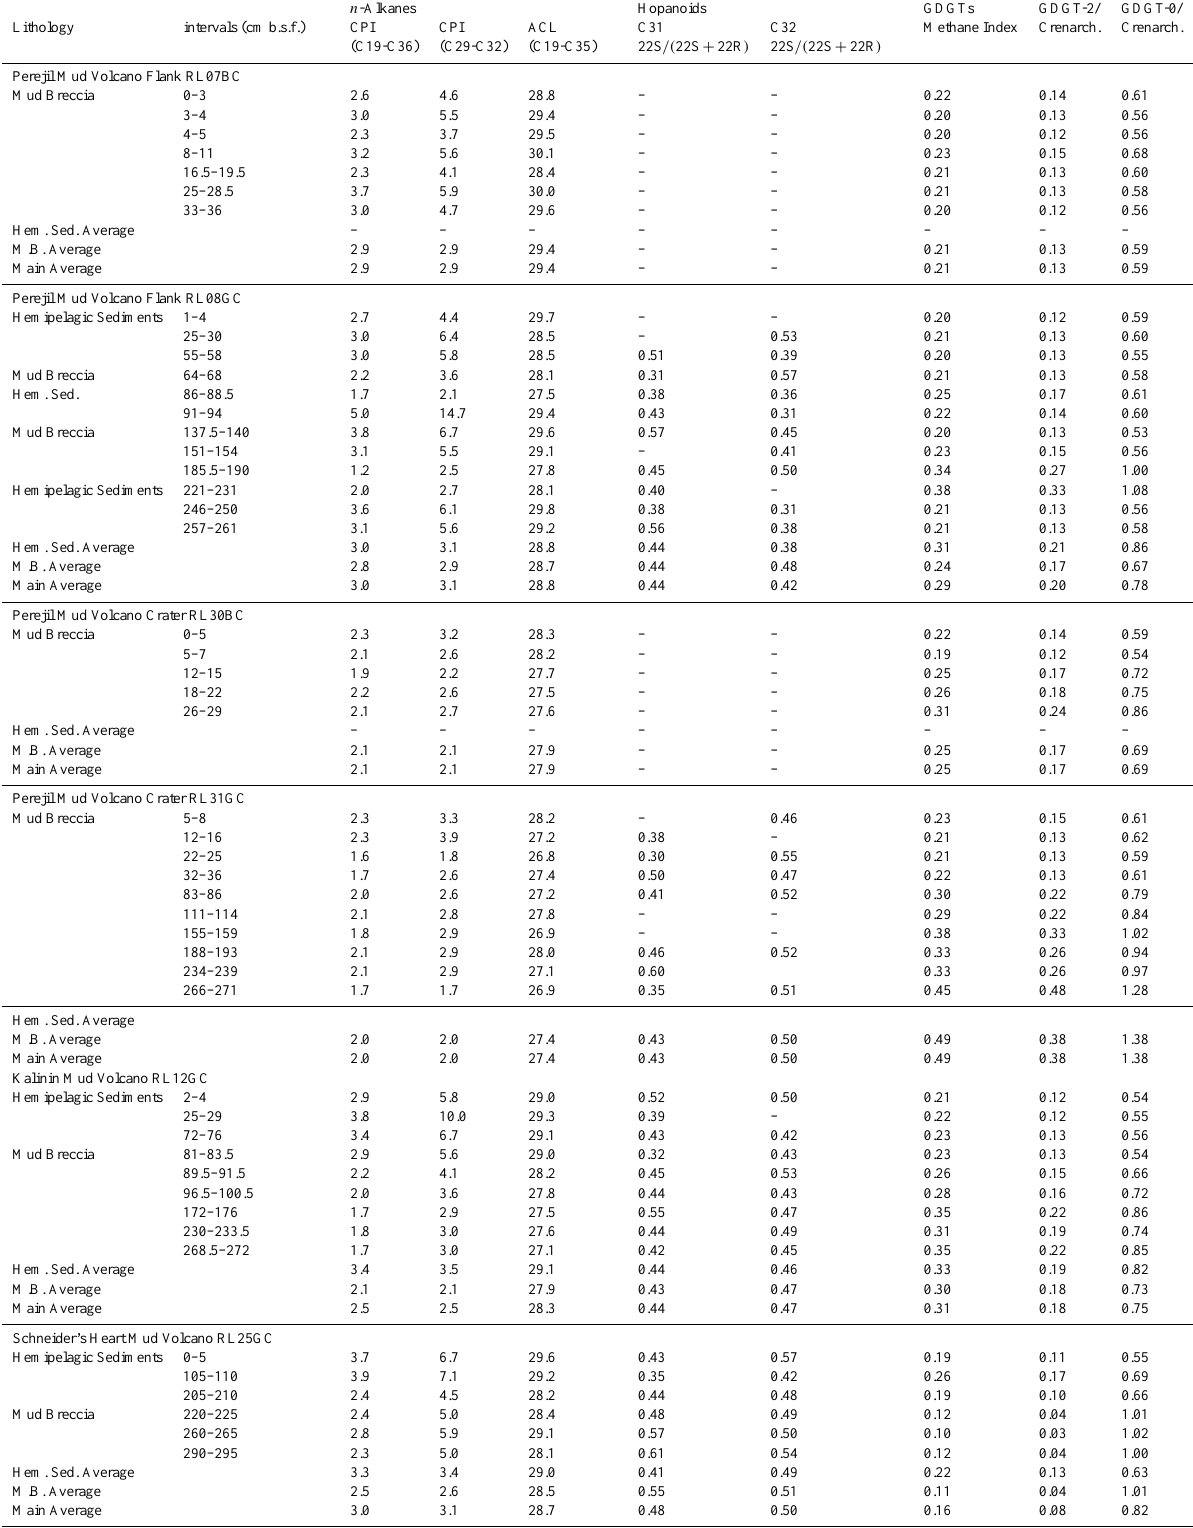
Table 2. Compound indices related with n alkanes (CPI and ACL), hopane and GDGTs-based ratios for the studied sites. n -Alkanes Hopanoids GDGTs GDGT-2/ GDGT-0/ Lithology intervals (cm b.s.f.) CPI CPI ACL C31 C32 Methane Index Crenarch. Crenarch. (C19-C36) (C29-C32) (C19-C35) 22S /( 22S + 22R ) 22S /( 22S + 22R